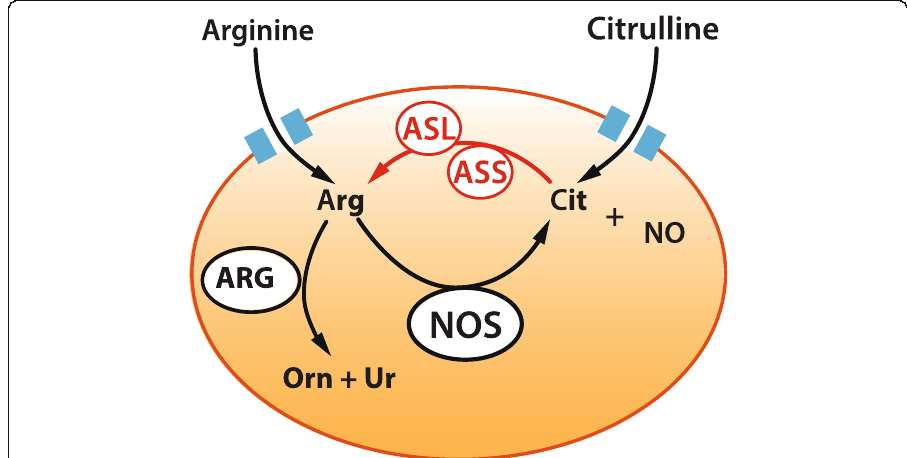
Fig. 3 Arginine bioavailability. Arginine (ARG) is transported into the cell via cationic amino acid transporters and is converted to citrulline (Cit) and NO. Citrulline derived from a number of sources including diet can be converted to arginine by argininosuccinate synthetase (ASS) and argininosuccinate lyase (ASL) increasing the available intracellular arginine. Arginase (ARG) metabolises arginine to ornithine (Orn) and urea